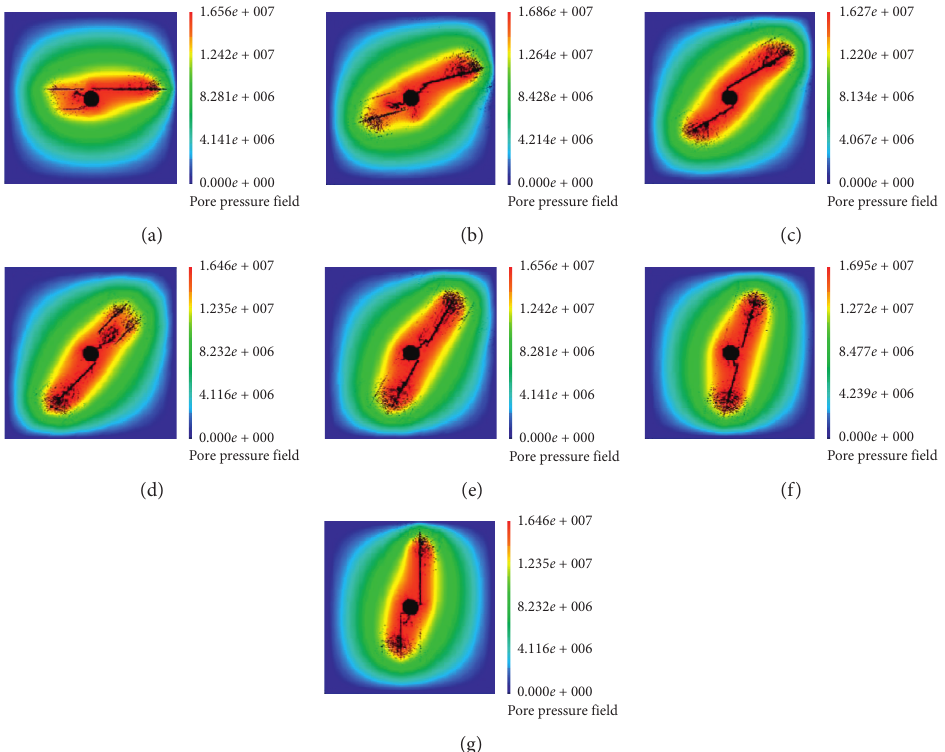
Figure 7: Pore pressure field of models without a confining pressure difference ( σ (d) α � 45 ° , (e) α � 60 ° , (f) α � 75 ° , and (g) α � 90 °